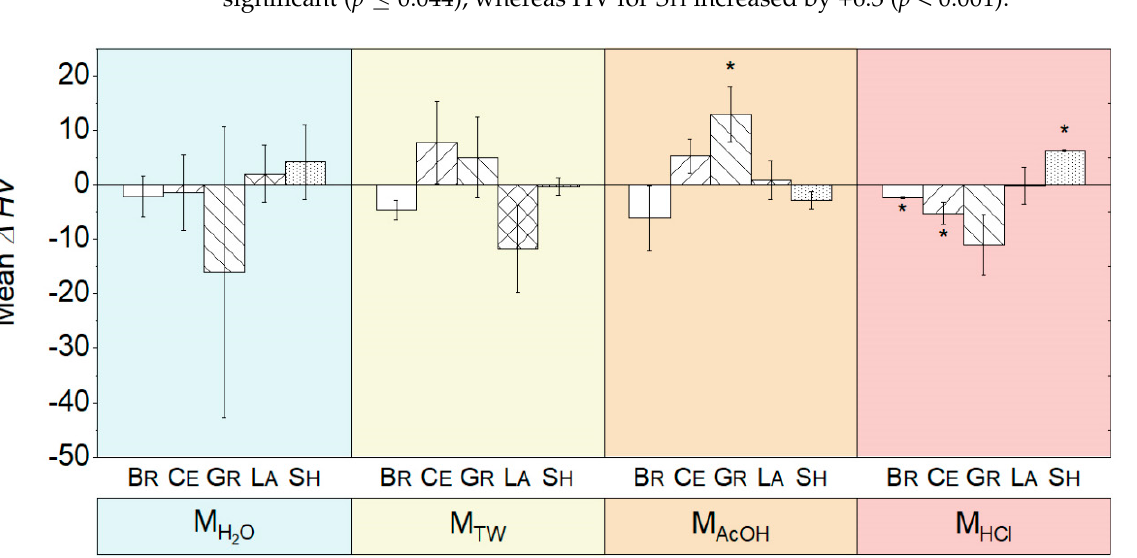
Figure 3. Changes in the mean and standard deviation of the Vickers hardness (HV) (t 1 − t 0 ) due to immersion in the different media M H2O (demineralized water), M TW (tonic water), M AcOH (acetic acid), and M HCl (hydrochloric acid) (* indicates p < 0.05).